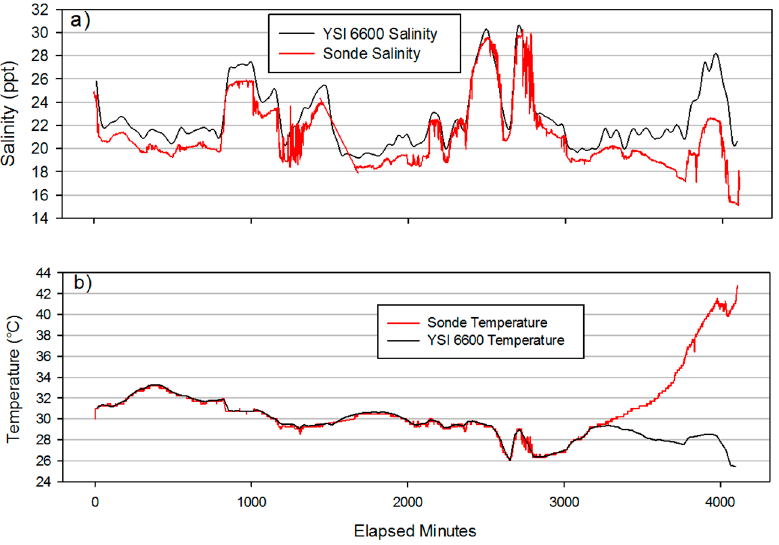
Figure 6. Comparison of salinity ( a ) and temperature ( b ) between the drifter configuration of the sonde and the Dauphin Island Sea Lab (DISL) Weather Station YSI 6600 from 1546 GMT August 24th 2015 to 1146 GMT August 27th 2015.